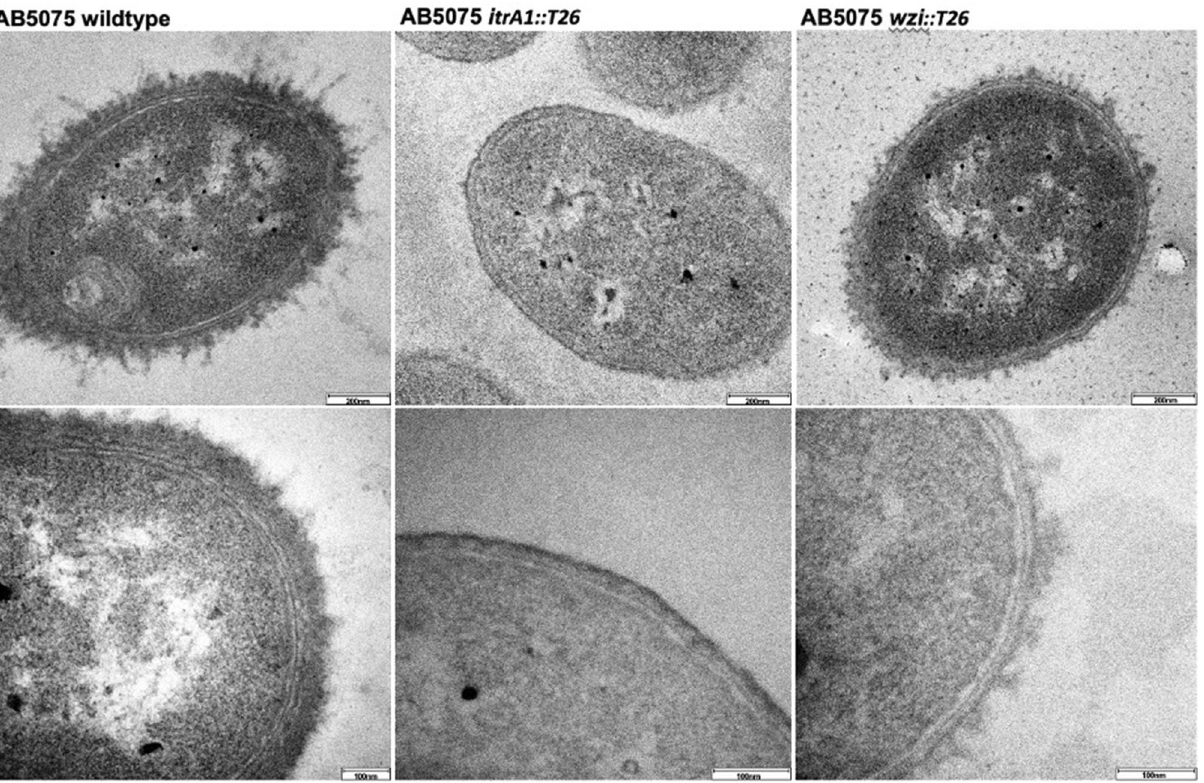
Figure 3. Transmission electron microscopy images of A. baumannii AB5075 wildtype, and representative wzi and itrA1 mutants. Cells stained with ruthenium red to visualize CPS. Top row shows an entire representative cell from each strain with a 200 nm scale. Bottom row is the magnified cell surface of each strain with a 100 nm